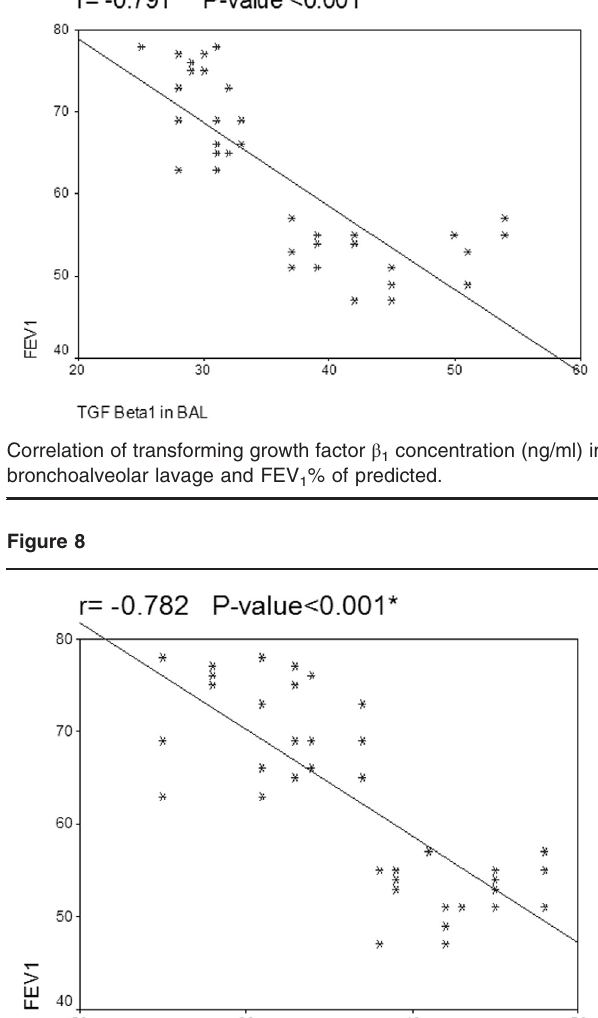
Correlation of 8-isoprostane concentration (ng/ml) in serum and FEV 1 % of predicted.